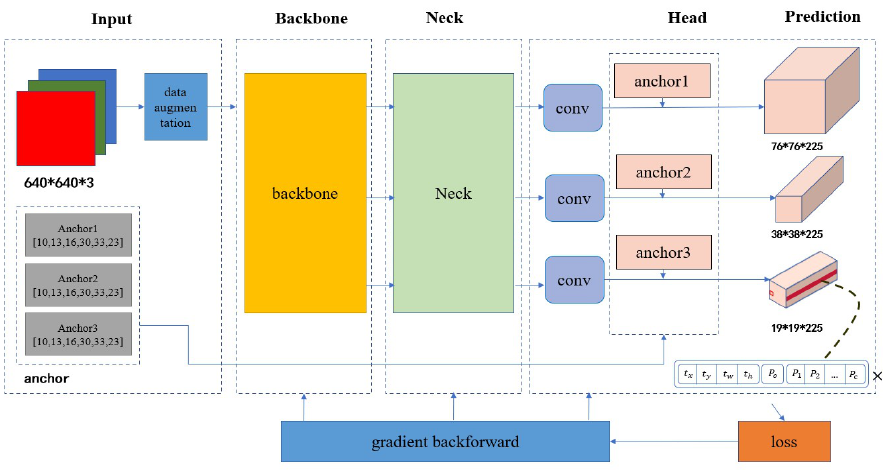
Figure 4. The network structure of the YOLO algorithm.